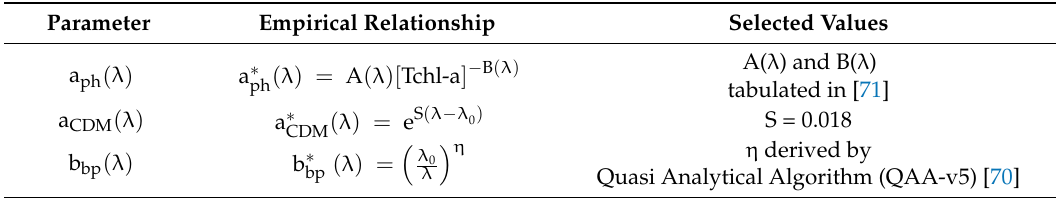
Table 3. Empirical relationship of the non-water components of absorption and scattering selected for the default GIOP